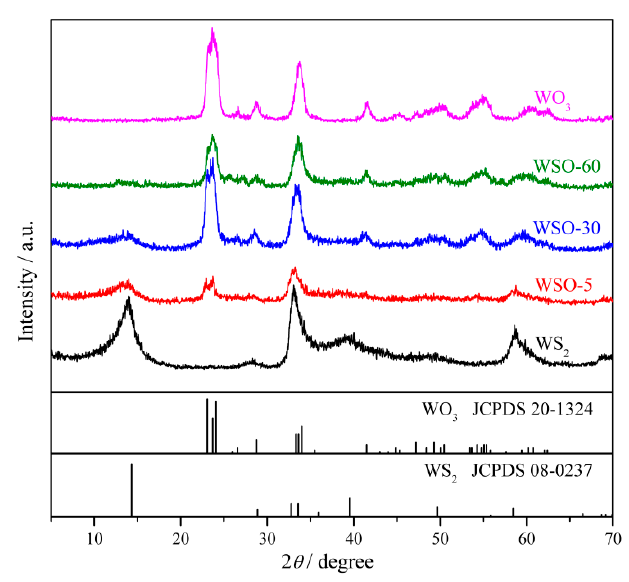
/ WO 2 3 , WS 2 , and WO 3